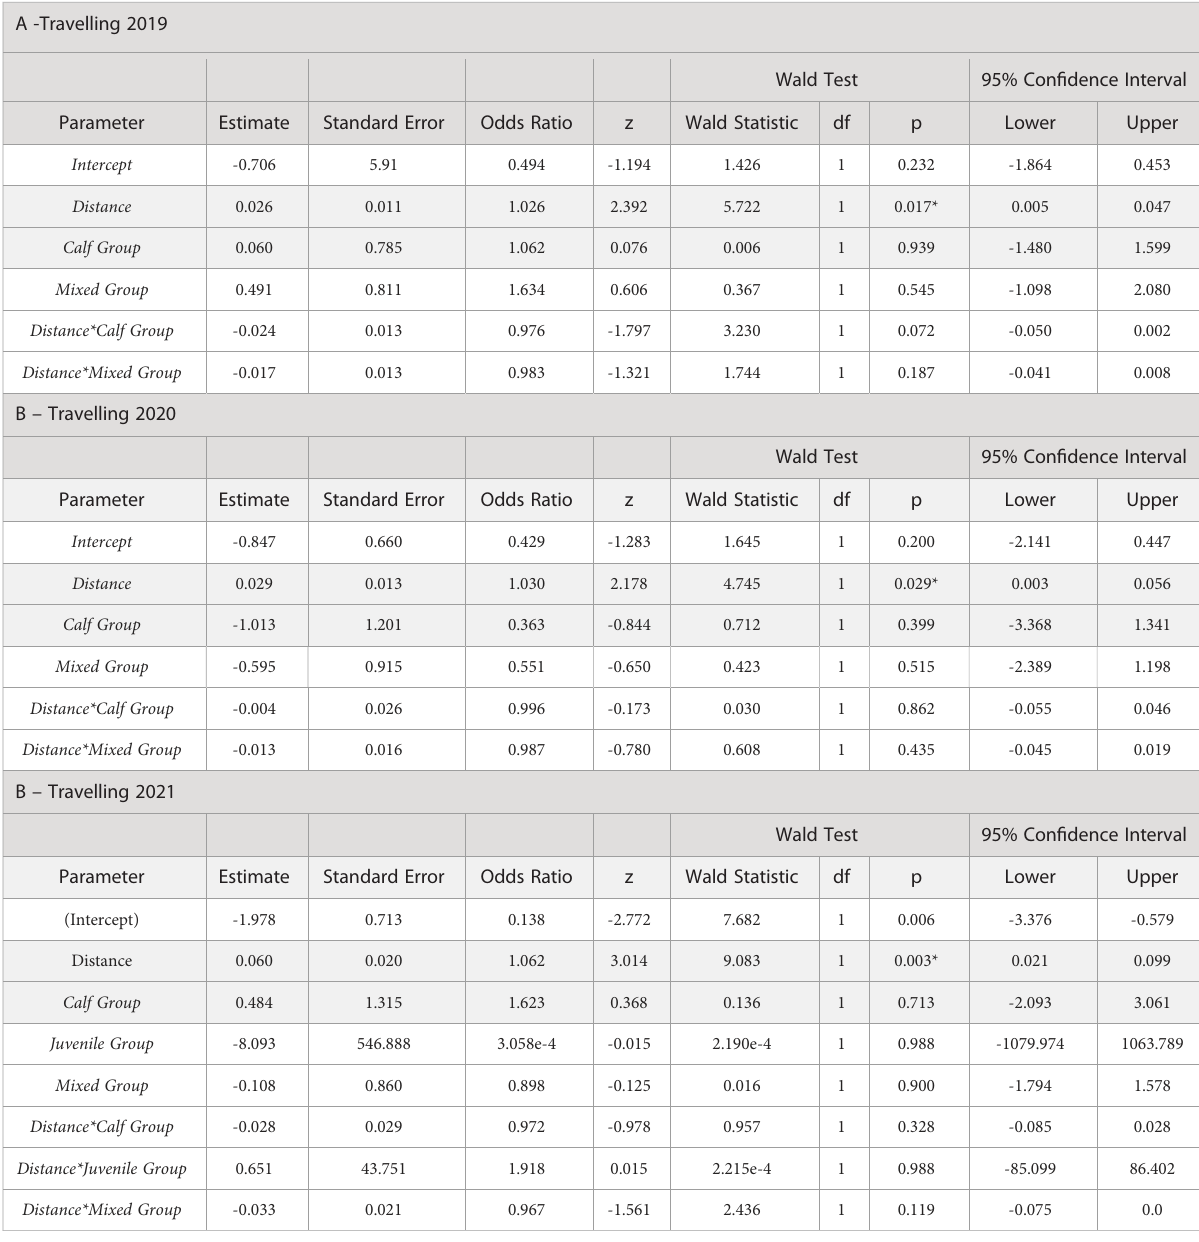
TABLE 9 Logistic regressions of Travelling frequencies observed from observation vessels, with Distance and Age Group as explanatory variables: A -Travelling seen from Sea North II in 2019; B- Travelling seen from Zodiacs in 2020; C- Travelling seen from Zodiacs in 2021 (* = signi fi cant at p<0.05)